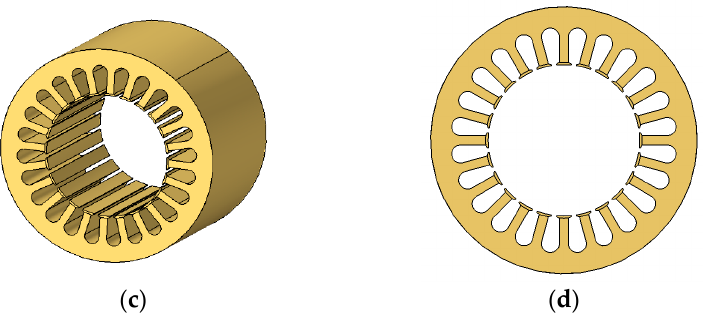
Figure 1. Geomety of PMSM ( a ) photograph, ( b ) 2D Cross section, ( c , d ) 3D stator.